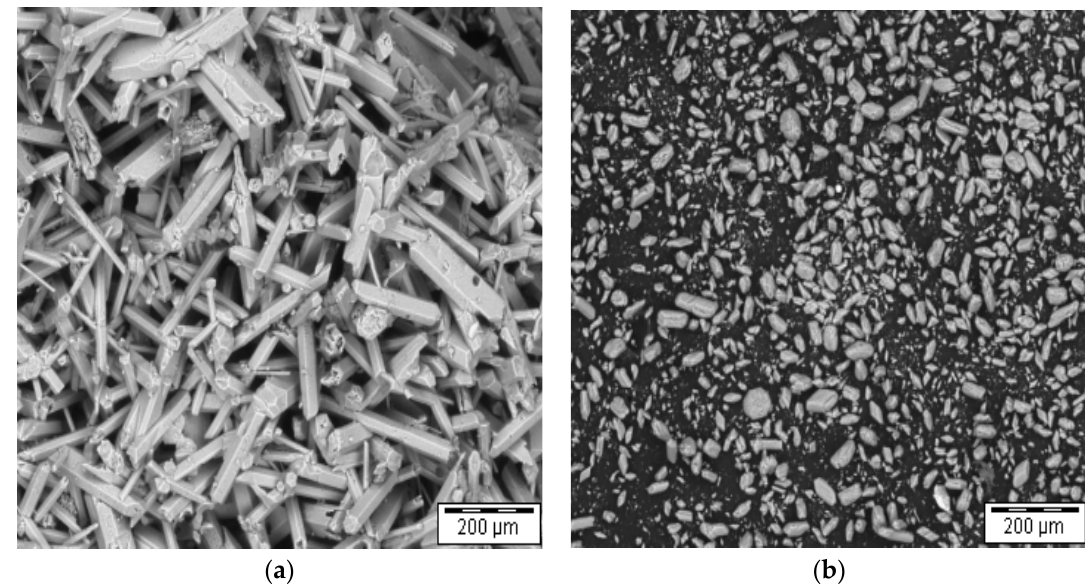
Figure 1. ( a ) α -HH, technical, steam autoclave; ( b ) β -HH, technical.